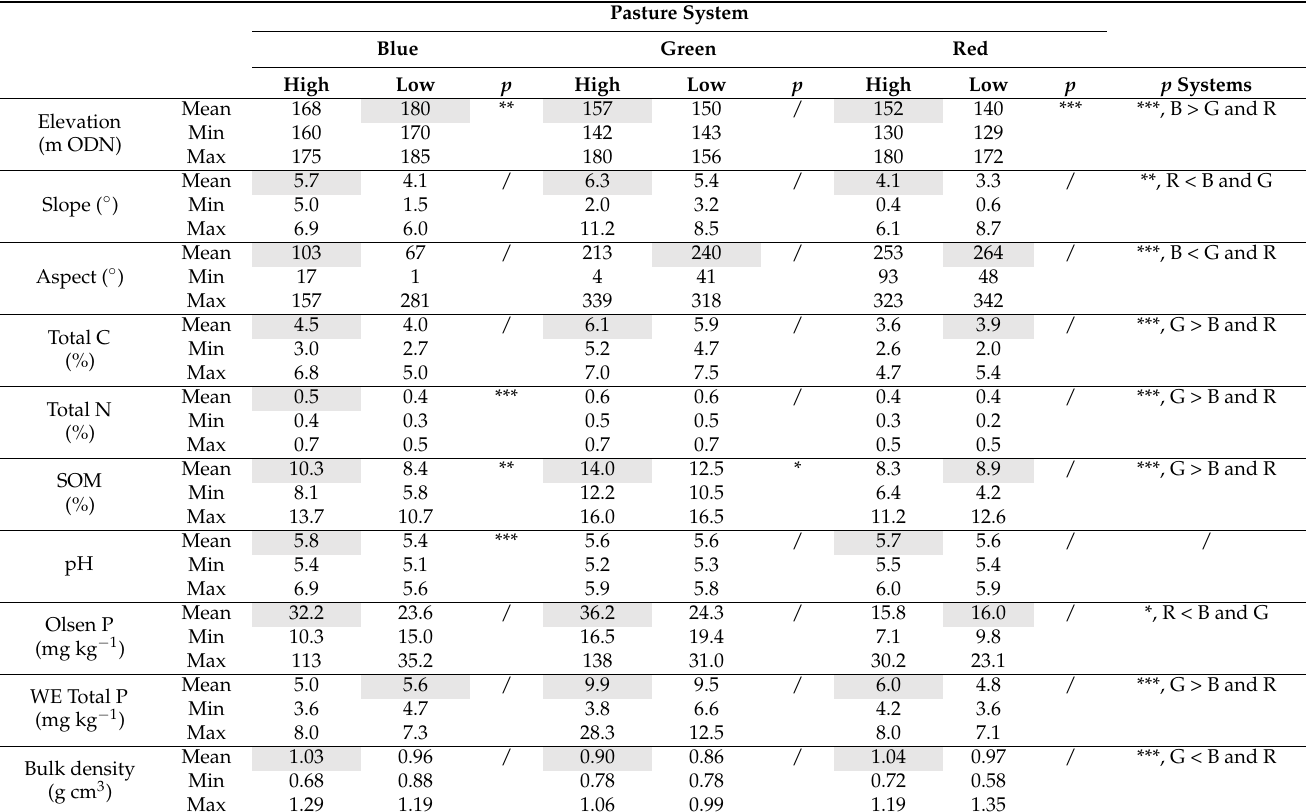
Table 2. Mean, minimum and maximum of the site and soil properties at points selected as high or low soil total micro-nutrient content; 8 high and 8 low points in each of the pasture systems: high-sugar grass + legume mix − N fertilizer (blue/HSG + L), permanent pasture + N fertilizer (green/P + N), high-sugar grass + N fertilizer (red/HSG + N). p = significance between high and low sites and between systems: * = p < 0.05, ** = p < 0.01, *** = p < 0.001. Grey highlight = highest